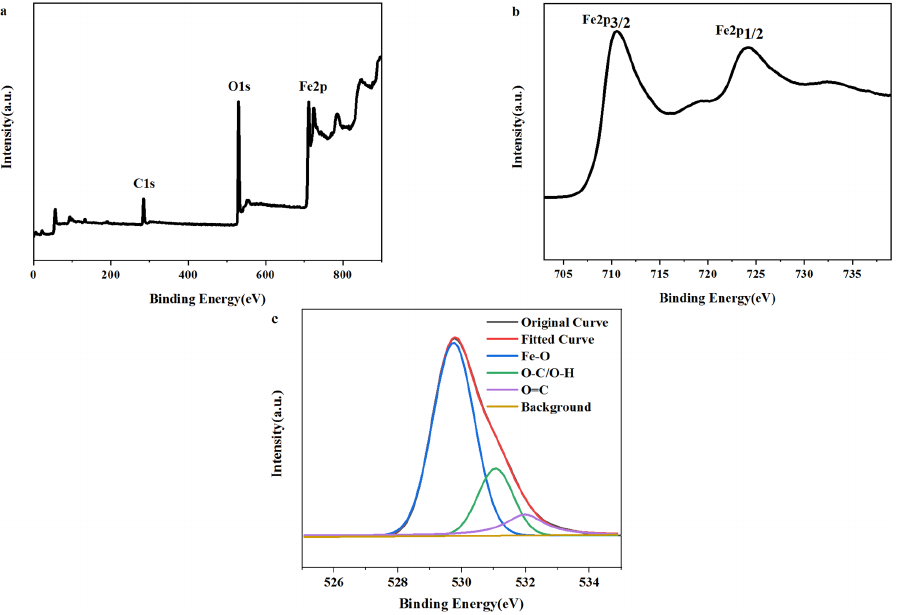
Figure 4. XPS spectra of the RGO/Fe 3 O 4 nanocomposites: ( a ) wide scan, ( b ) Fe 2p spectra, ( c ) O 1s spectra.